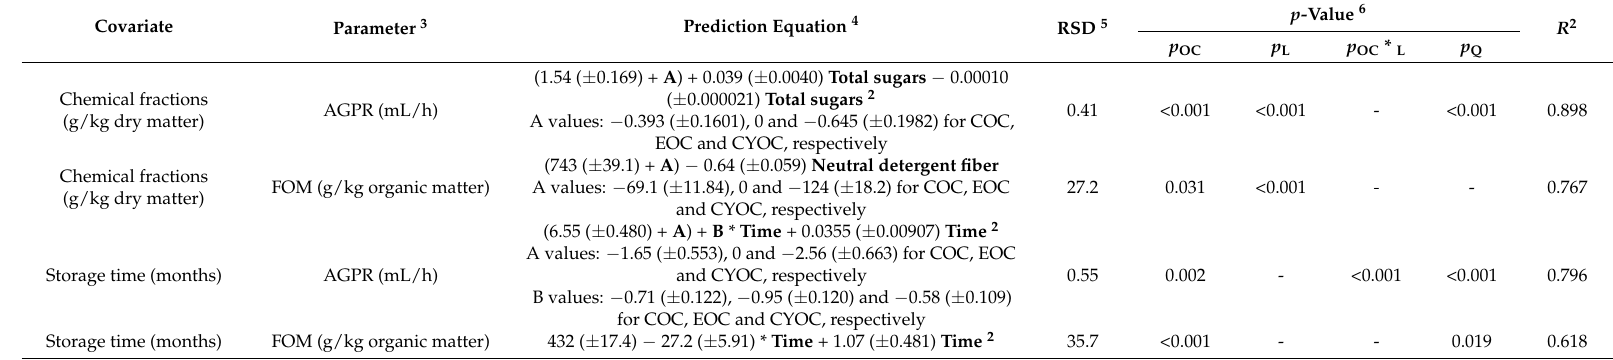
Table 5. Models for predicting the average gas production rate (AGPR; mL/h) and fermented organic matter (FOM; g/kg OM) after 24-h in vitro incubation of olive cake (OC) samples using OC type (crude (COC), exhausted (EOC) and cyclone (CYOC)) as the fixed effect and either chemical fractions or storage time as covariates ( n = 42) 1